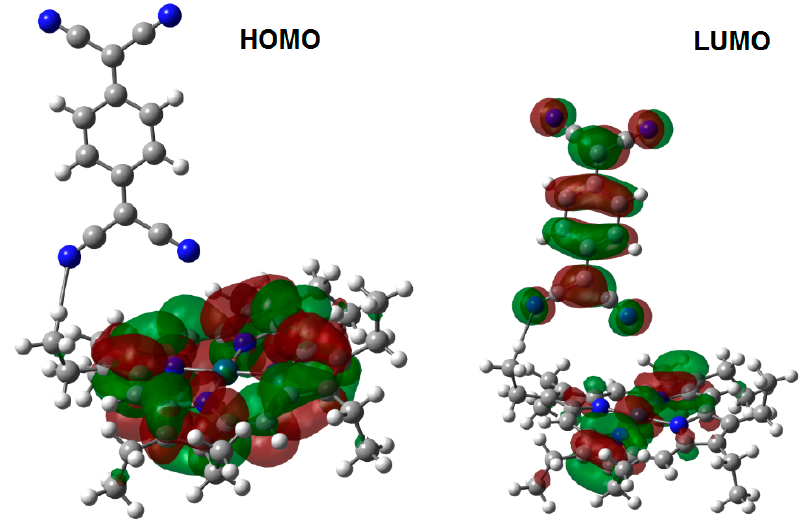
Figure 3. Frontier molecular orbitals of the cobalt(II) porphyrin complex with hydrogen bonds with an aliphatic source.